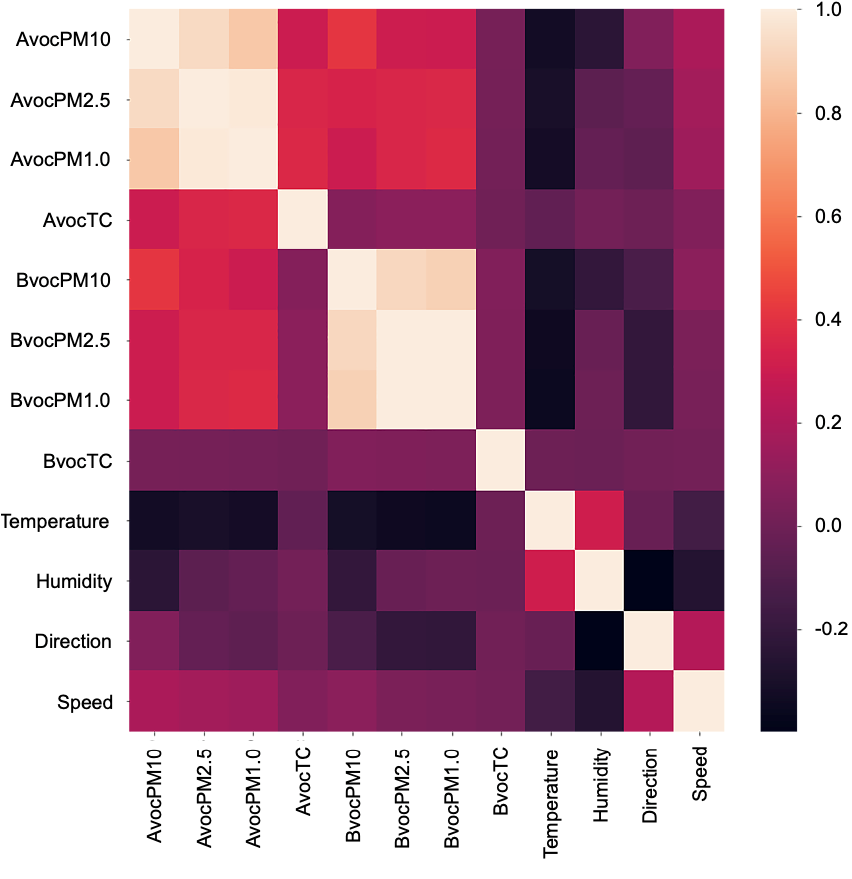
Figure 5. Feature correlation